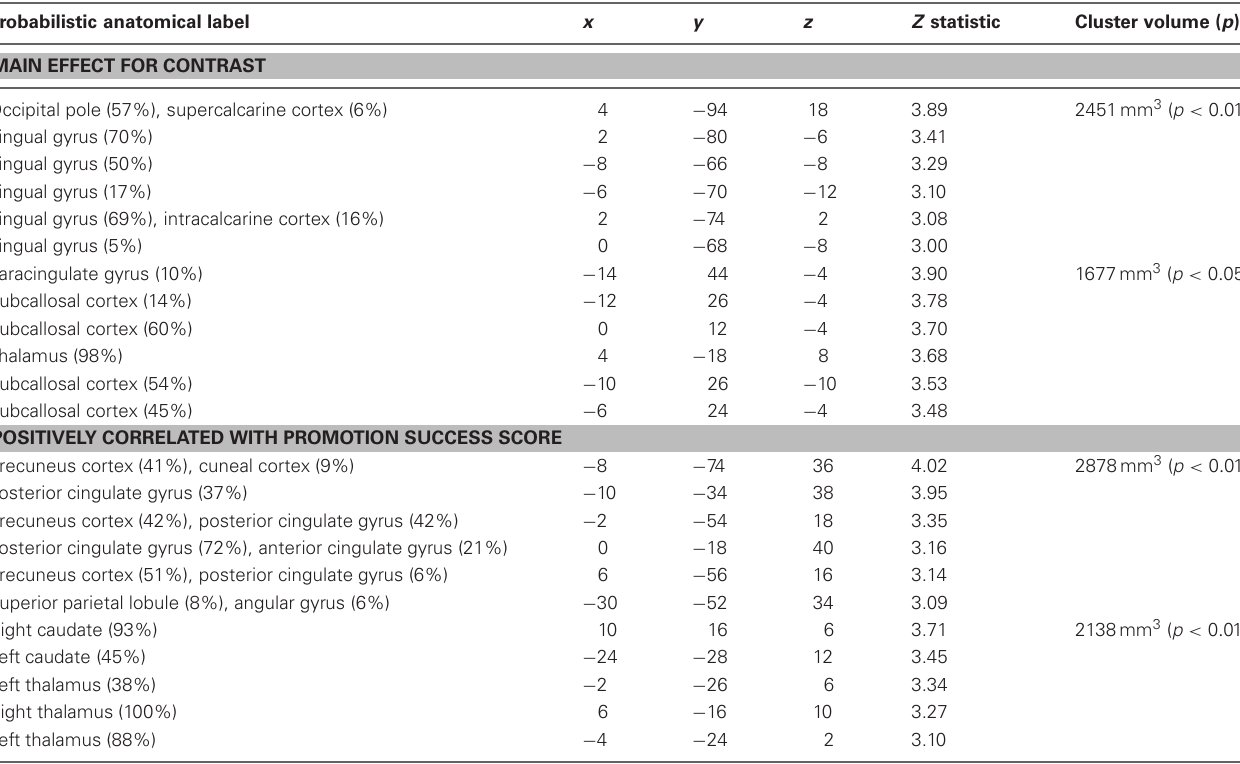
Coordinates of local maxima within each cluster of activation are in MNI space. Probabilistic labels reflect the likelihood that a coordinate belongs to a given region; for clarity, only labels whose likelihood exceeds 5% are shown.